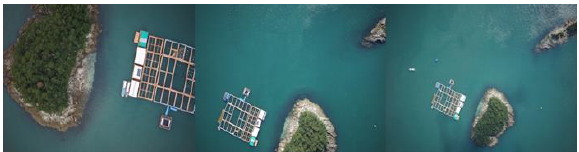
Figure 6. Sample images of dataset in Tongyeong, South Korea